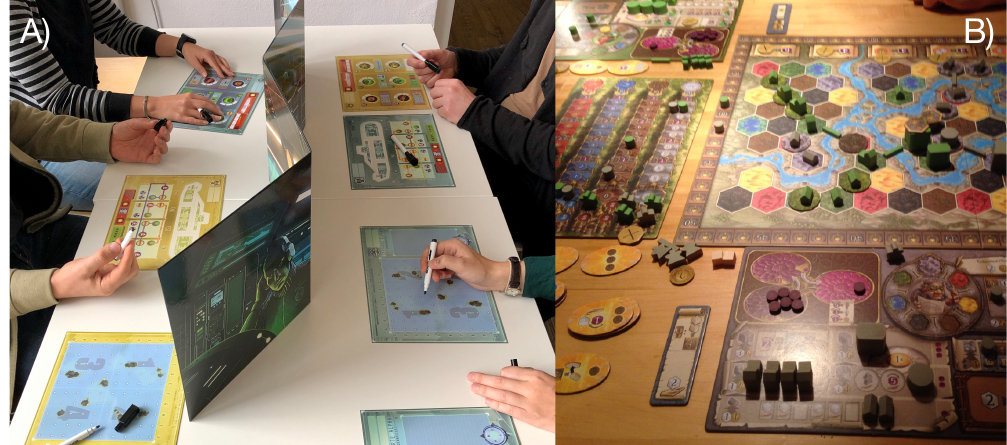
Figure 2. Different concepts of how the game board affords players’ positions around a table and how this relates to roles, different interactional spaces and distribution of information: ( A ) two teams compete in Captain Sonar [46] with each player having a different role within the game; and ( B ) shared and individual player boards side by side in Terra Mystica